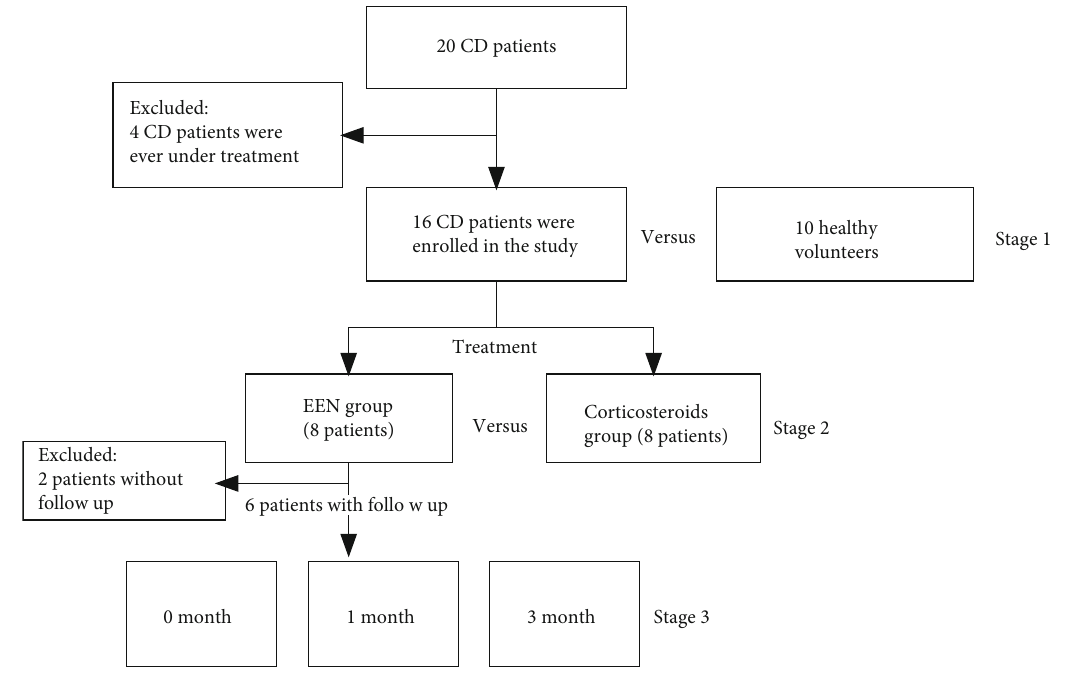
Figure 1: The fl ow chart of the three-stage research.